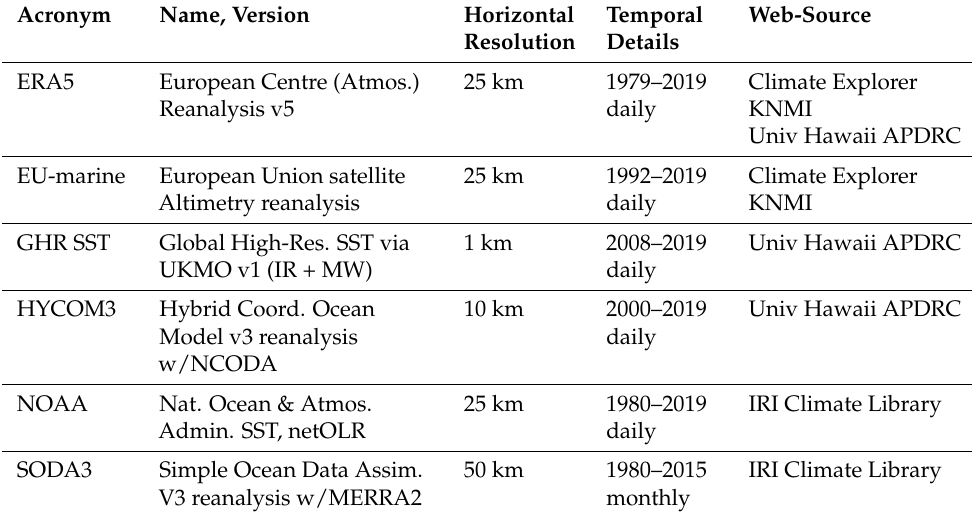
Table 1. Listing of